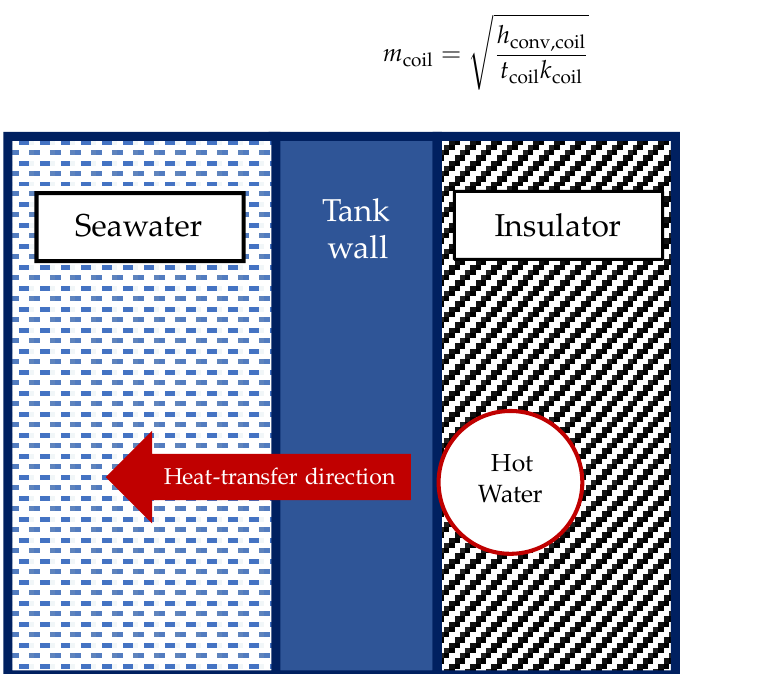
Figure 10. Heat-transfer direction from the water inside the coil heater to the fluid inside the tank.